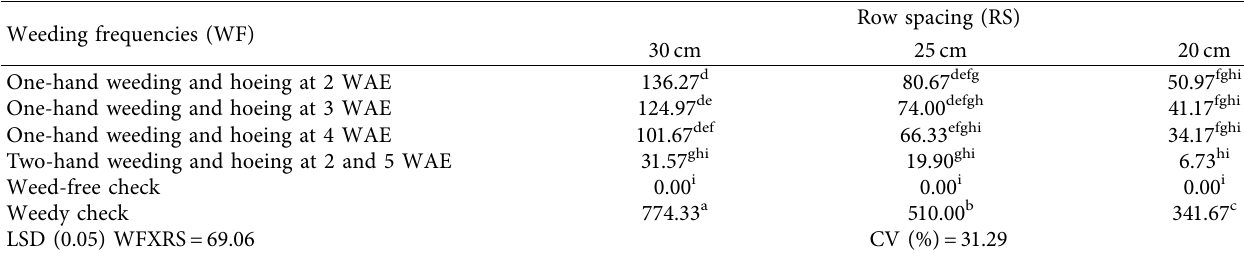
Table 2: Interaction effects of row spacing and weeding frequencies of rice on weed dry weight at harvest (g · m − 2 ) at Kuja in 2020 main cropping season.